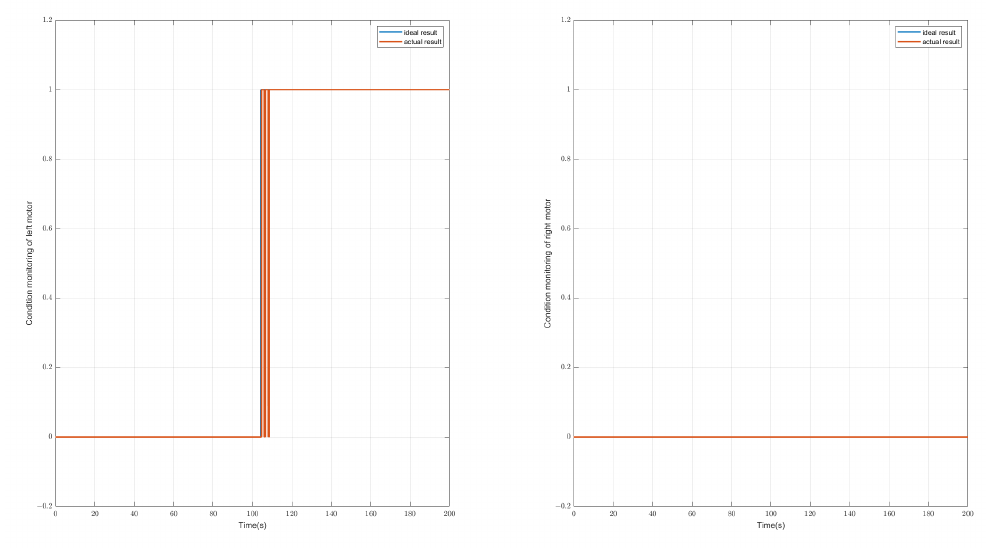
Figure 17. The diagnostic result of condition monitoring of the driving motors. This case shows that the left driving motor fails at 104 s. (left: results for left motor, right: result for right motor, blue line: real state of the driving motor, red line: diagnostic state of the driving